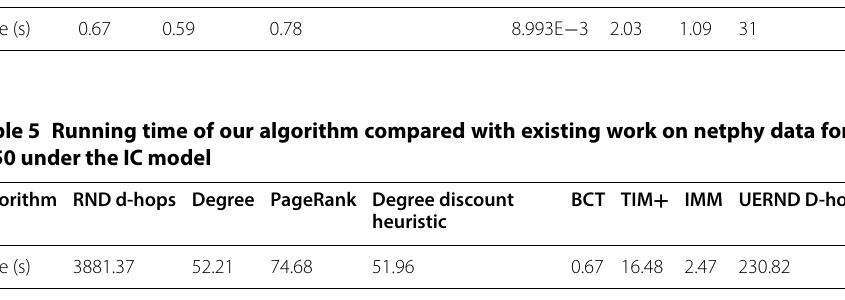
Table 4 Runtime of algorithms on Nethept data for K Algorithm Degree PageRank Degree discount heuristic BCT